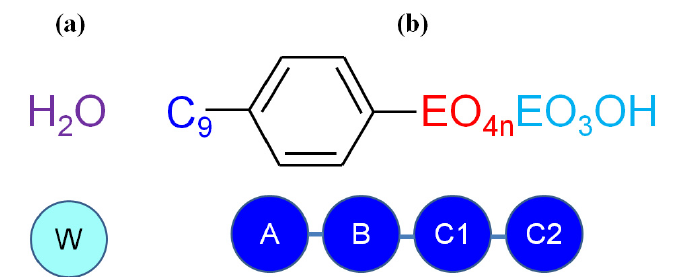
Figure 3. Molecules used in DPD simulations and their respective coarse-grained model ( a ) water (solvent), ( b ) NPE (surfactant), where the EO chain can be seen as: NPE-4 (EO OH); NPE-7 (n = 1), NPE-11 (n = 2), NPE-15 (n = 3). 4